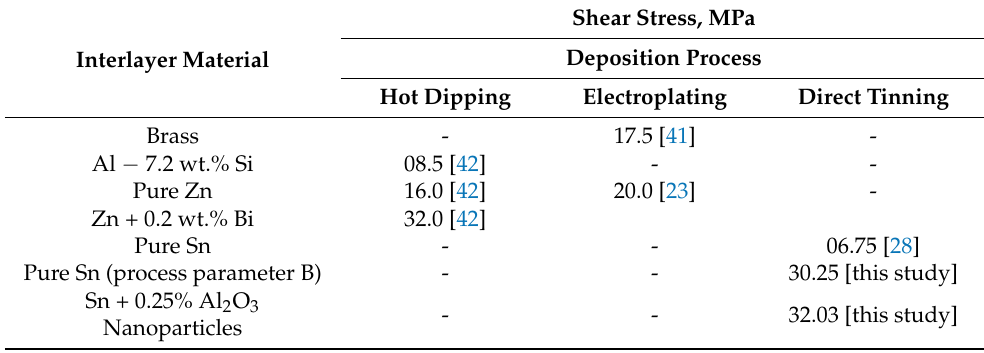
Table 5. Reports on the shear property of Al/Fe bimetallic composites for different interlay materials and deposition processes in the literature.